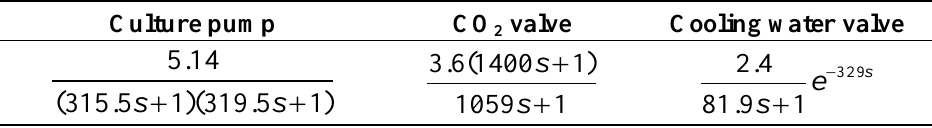
Table B1. Transfer functions of the identified models.